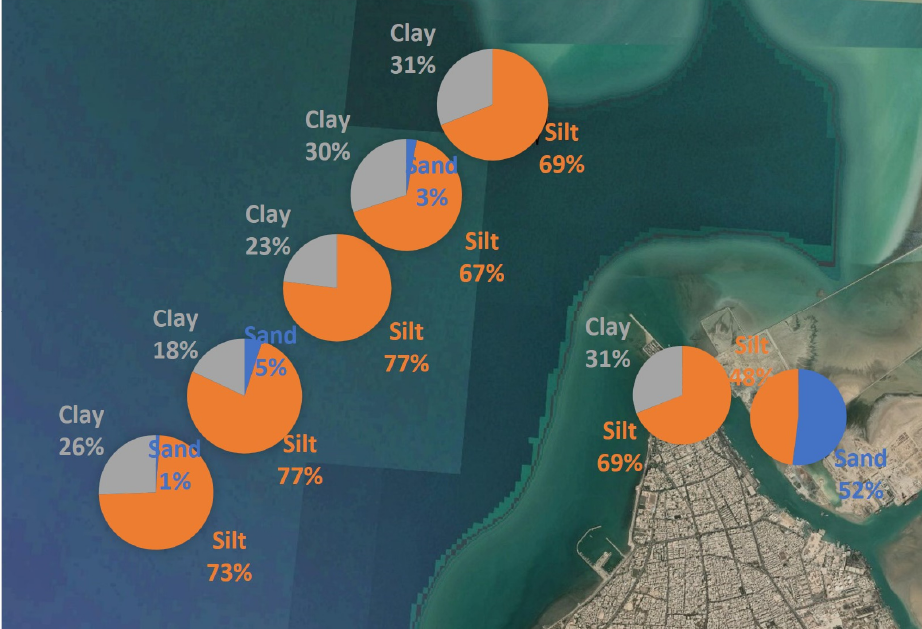
Figure 8. Distribution of grain-size fractions (sand, silt, and clay) in all surface sediment samples within the study area.